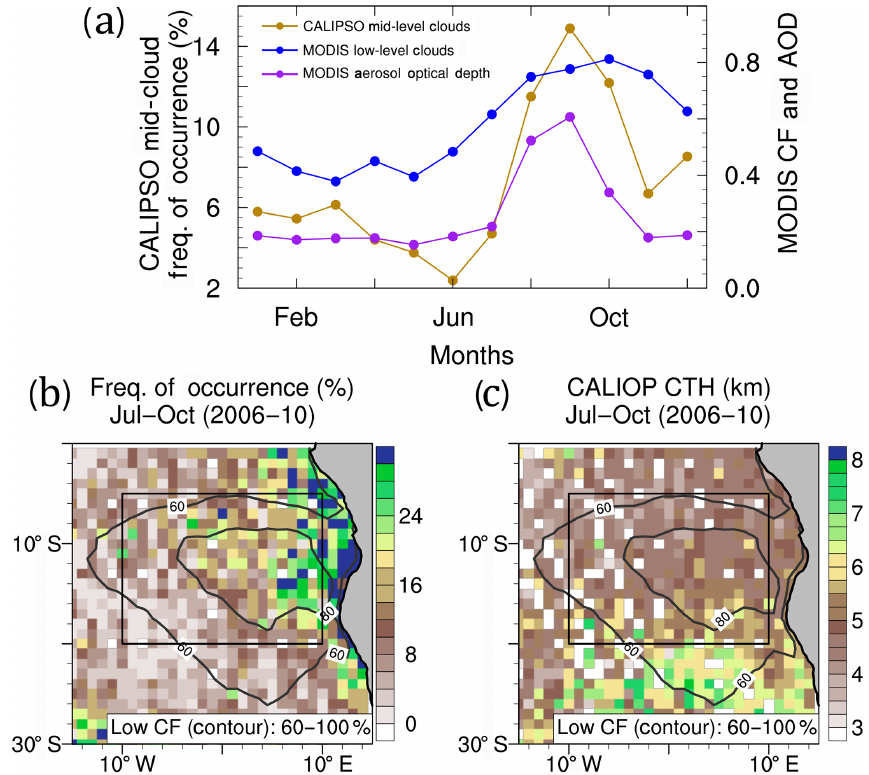
Figure 4. (a) Monthly averages (2006–2010) of the CALIPSO mid-level cloud frequency of occurrence (%; brown line) and MODIS low- level cloud fraction and aerosol optical depth (CF and AOD; right axis), all averaged over the ORACLES-2016 campaign region (defined here as 5 ◦ –20 ◦ S and 10 ◦ W–10 ◦ E; black boxes in b and c ). (b) The spatial distribution of the July–October average for the CALIPSO mid-level cloud frequency of occurrence (%) and (c) the corresponding cloud-top heights (km). The black contours in both (b) and (c) are the MODIS liquid-water low-level cloud fraction (%) for the same period. The CALIPSO mid-level clouds are identified as the cloud-top layer between 3 and 8km, while the MODIS low-level clouds are averages of grid boxes with cloud-top temperatures greater than